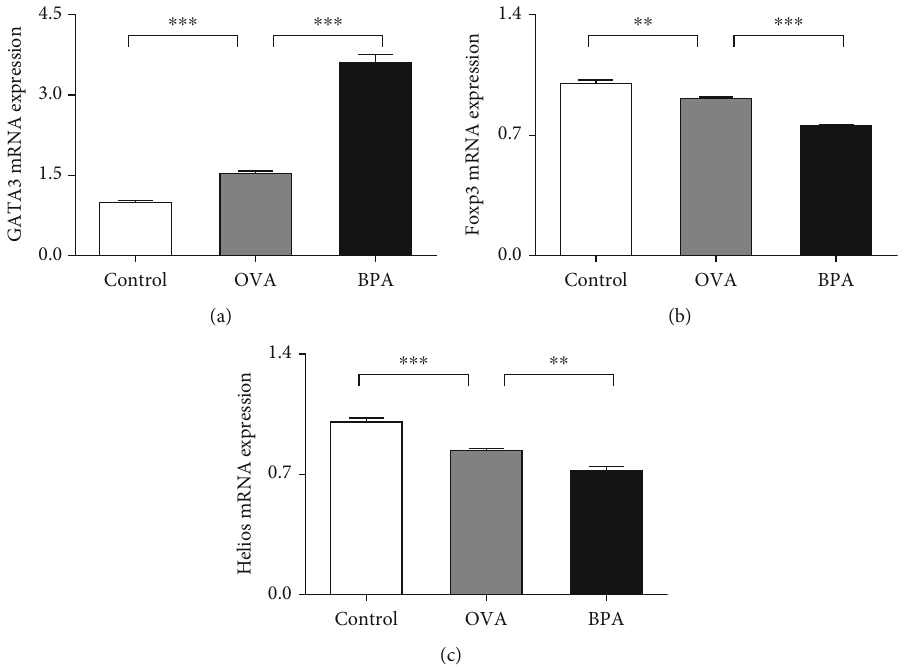
Figure 5: BPA increased the levels of the Th2 cell-speci fi c transcription factor GATA-3 and reduced those of the Treg-speci fi c factors Foxp3 and Helios. RT-PCR data on (a) GATA-3, (b) Foxp3, and (c) Helios mRNA expression levels in nasal mucosa. Data are expressed as means ± SEM ; n = 5 in each group. ∗∗ P < 0 : 01 ; ∗∗∗ P < 0 : 001